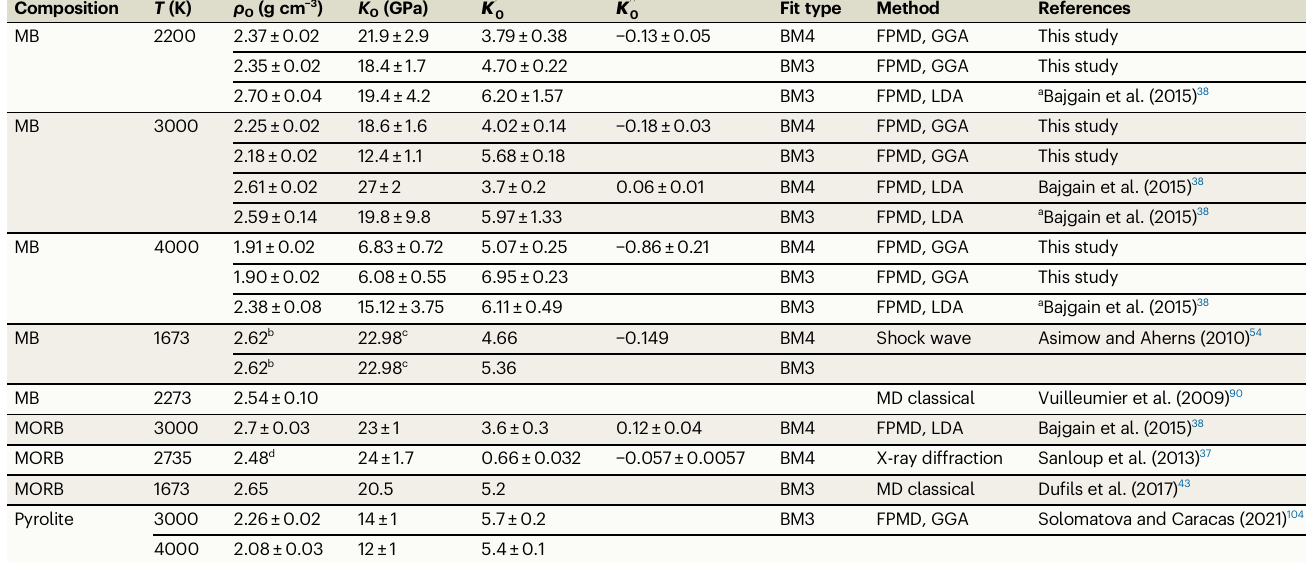
) for silicate melts 0